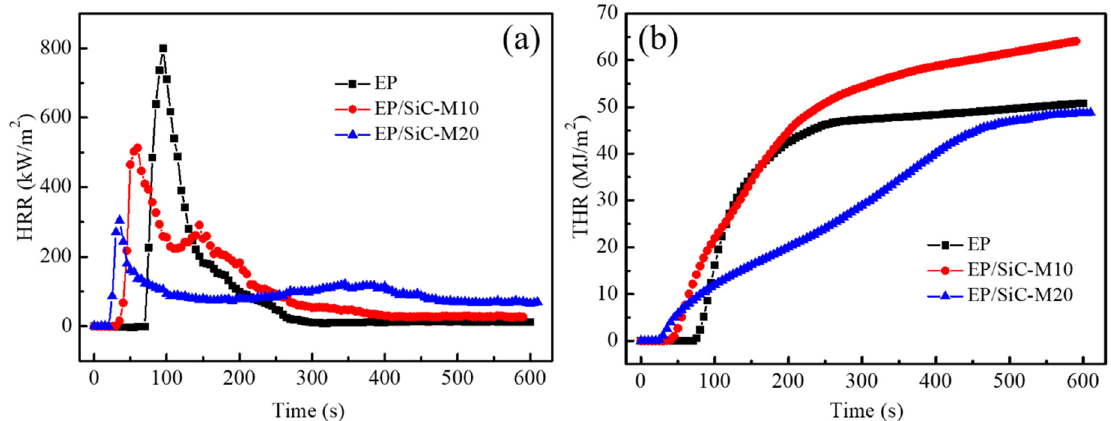
Figure 6: Heat release rate ( a ) and total heat release ( b ) versus time curves of EP and composites EP/SiC -